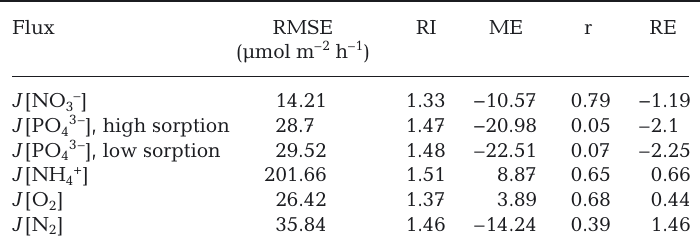
Table 3. Root mean square error (RMSE), reliability index (RI), mean error (ME), correlation coefficient (r), and relative error (RE) for model–data comparison of sediment–water NO 3– , PO 43– , NH 4+ , O 2 , and N 2 fluxes. April to September conditions at the farm site were as follows (mean